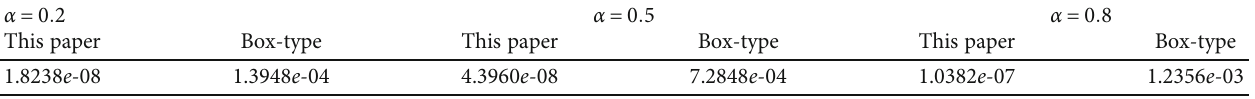
Table 3: Maximum pointwise errors for the new method and for the box-type di ff erence scheme [18].